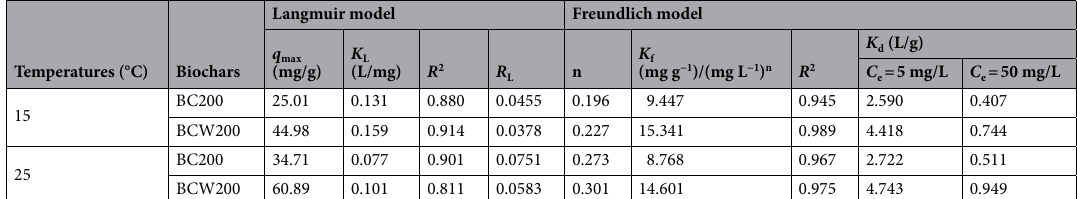
Table 4. Parameters of the sorption isotherms fitted with the Langmuir and Freundlich